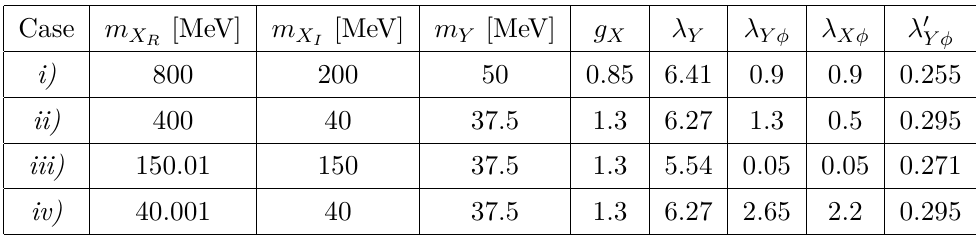
Table 1 . Input parameter values for the four benchmark cases. Cases i) and ii) correspond to the two-component scenarios and cases iii) and iv) correspond to the three-component scenarios. We chose m = 200 MeV, m = 30 GeV, λ = 0 . 025 , α = 10 − 2 , and (cid:15) = 2 × 10 − 4 . Our four Z 0 h 0 X benchmark cases are marked as blue points in figures 1 and